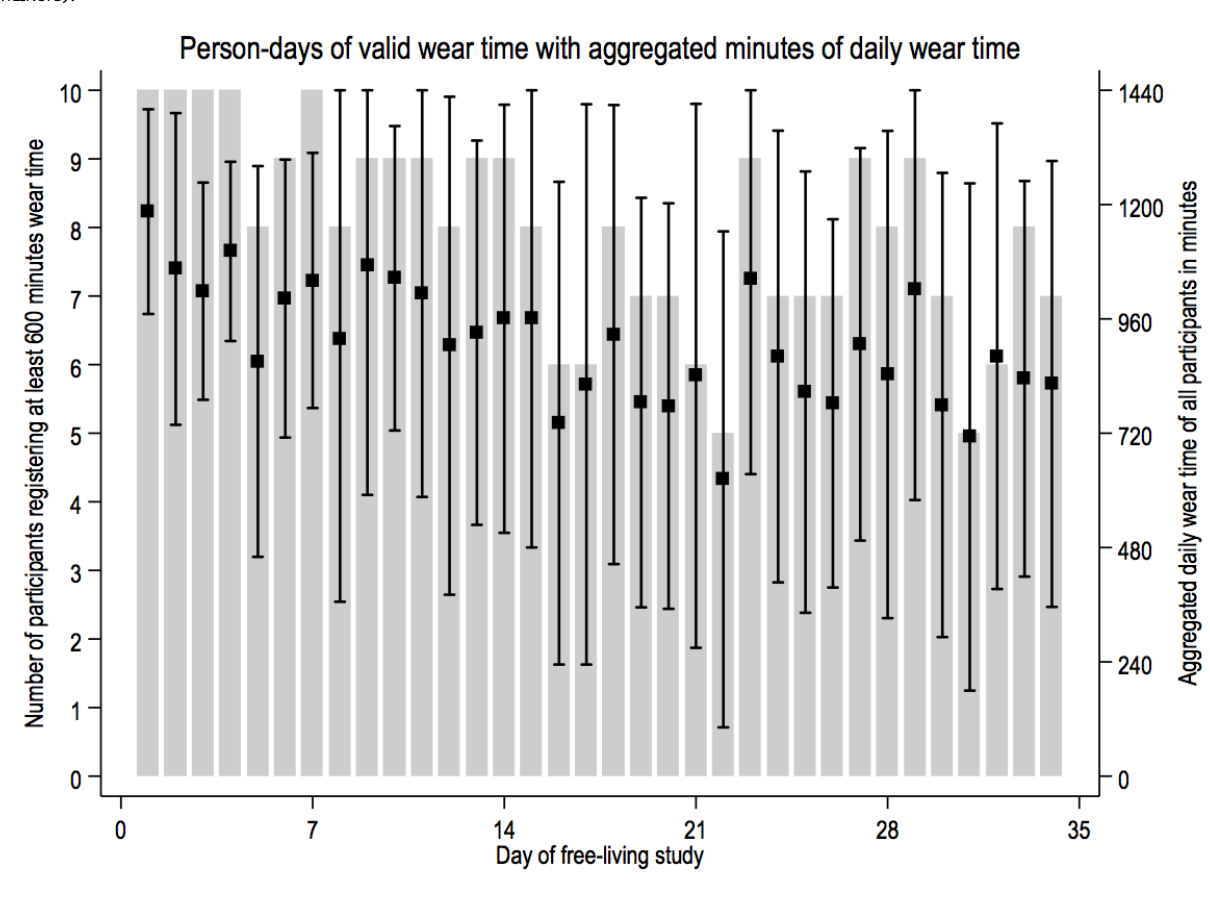
Figure 4. Number of participants with valid days (gray bars) with distribution of aggregated wear time means (boxes) and one standard deviation